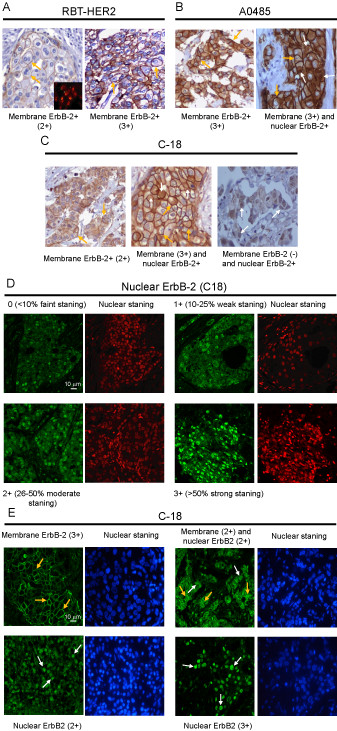
Cellular localization of ErbB-2 in tumor samples. A. IHC staining using RBT-HER2. Representative tumors with 2+ and 3+ scores of membrane ErbB-2 expression (400×). Inset shows FISH of ErbB-2 gene amplification in the tumor scored 2+ (1000×). B. IHC of ErbB-2 (400×) using A0485. Representative tumors showing only membrane ErbB-2 or membrane and nuclear ErbB-2 staining C. IHC of ErbB-2 (400×) using C-18. Examples of tumors showing exclusively membrane, membrane and nuclear or only nuclear positivity. D and E. IF staining of ErbB-2 with C-18. D. Nuclear ErbB-2 score. Nuclei were stained with propidium iodide (red). E. Examples of tumors showing only membrane, membrane and nuclear, and exclusive nuclear ErbB-2 expression (+2 and +3 scores). Nuclei were stained with DAPI (blue). In A to C and in E orange arrows indicate membrane ErbB-2 positivity and in B, C, and E white arrows indicate nuclear ErbB-2 presence. Membrane ErbB-2 levels in both IHC and IF were scored according to the American Society of Clinical Oncology/College of American Pathologists (ASCO/CAP) guidelines for ErbB-2/HER2 testing [13]. A score 0 represents no staining, 1+ weak, incomplete membrane staining in any proportion of tumor cells, 2+ complete membrane staining that is either non uniform or weak but with obvious circumferential distribution in at least 10% of tumor cells, or invasive tumors showing intense, complete membrane staining in 30% or fewer tumor cells, 3+ strong complete membrane staining in > 30% of tumor cells.